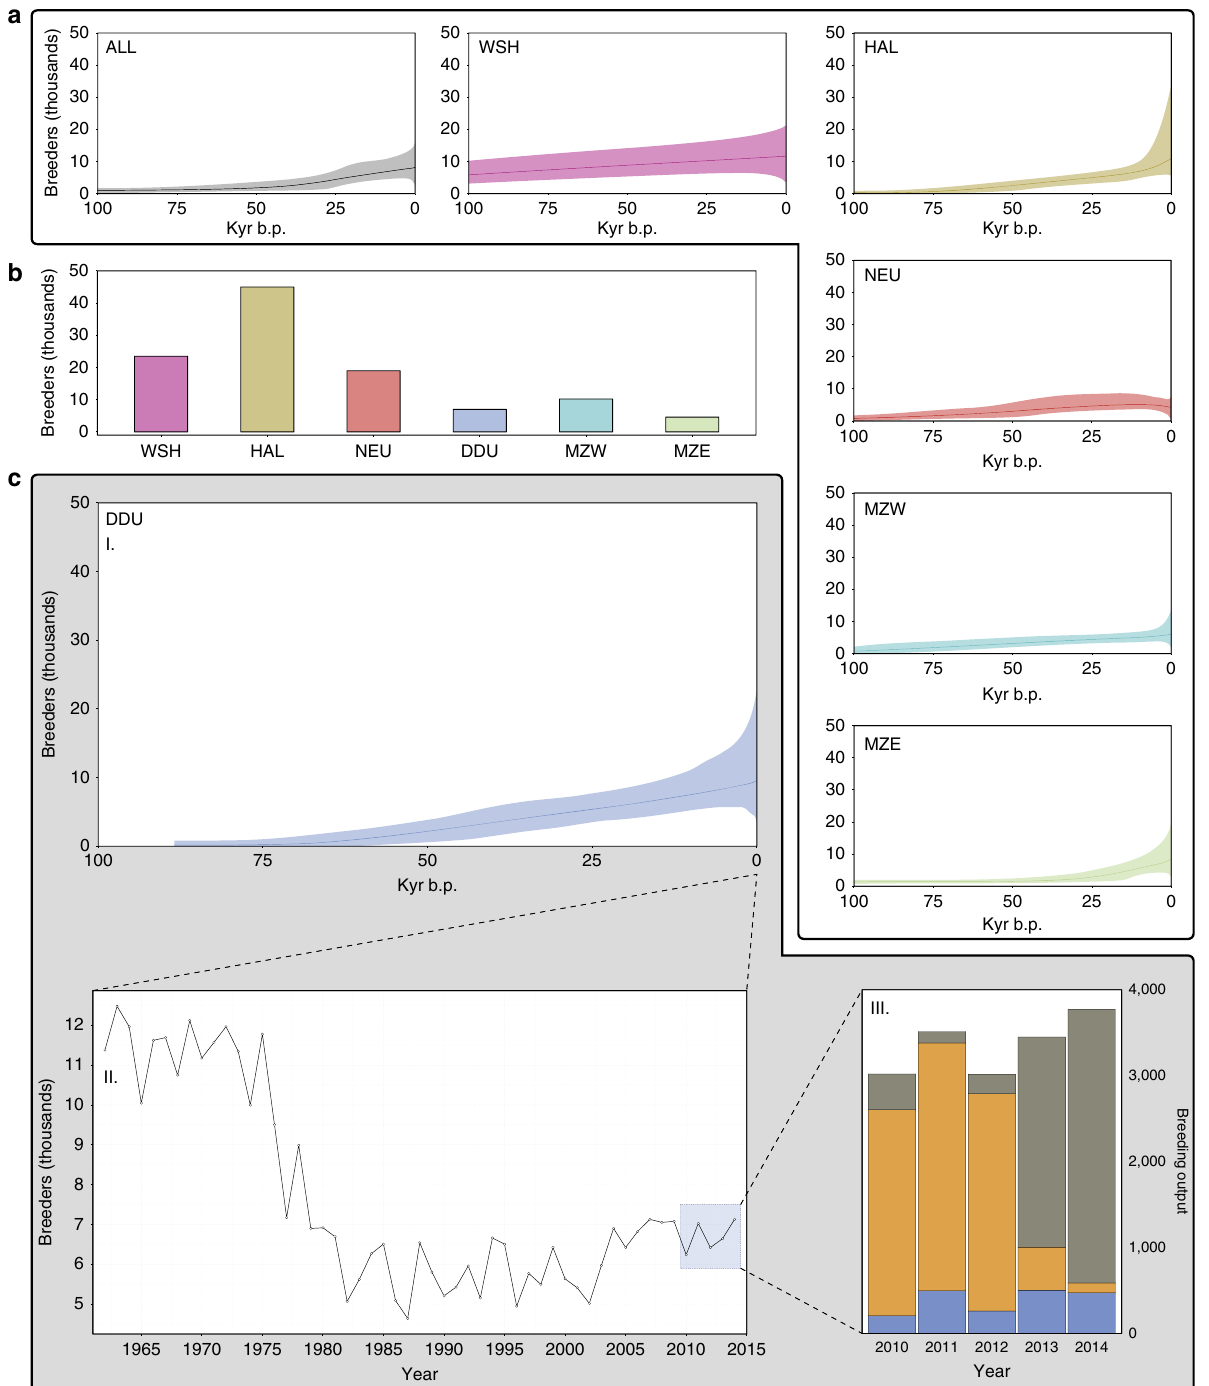
Figure 2 | Demography is a matter of scale. ( a ) Demographic reconstructions (extended bayesian skyline plots), for all samples, and per-colony (ALL, all sampled colonies pooled together; DDU, Pointe Ge´ologie near Dumont D’Urville station; HAL, Halley Bay; MZW, Mertz West; MZE, Mertz East; NEU, Neumayer; WSH, Cape Washington). Solid line: mean population size. Shaded area: 95% confidence interval. Blue area: Last Glacial Maximum (LGM). ( b ) Census size for the six analysed colonies (from Fretwell et al. 35 and Ancel et al. 20 ). ( c ) Three different demographic timescales for DDU colony: I. coalescent-scale (EBSP reconstruction), II. monitoring-scale (from Barbraud et al. 36,70 and Le Bohec, personal communication, 2016), III. recent catastrophic breeding failure: blue, eggs lost during brooding; grey, chicks found dead; orange, successfully fledged chicks (from Barbraud et al. 70 and Le Bohec, personal communication, genetic fragmentation, which is known to reduce effective region 32 , a difference probably explained by the contrasting breeding habitats and strategies of the two species, the King penguin being dependent on year-round ice-free breeding sites. The inferred long-term demographic stability also excludes past